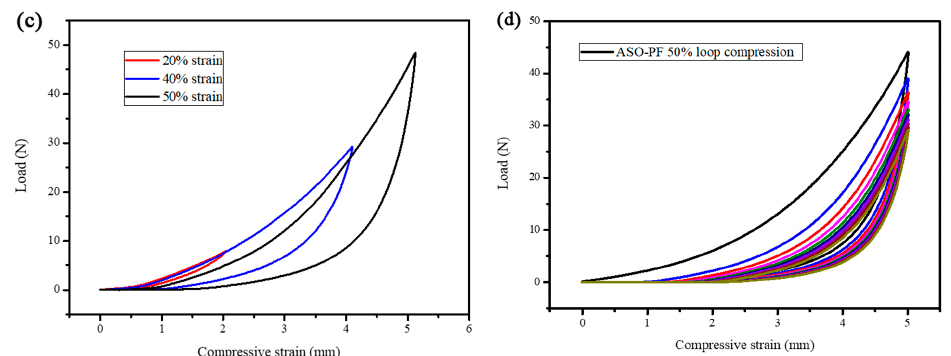
Figure 4. Compressive stress–strain curves of PF and ASO-PF. ( a ) Maximum compressive deformation of PF and ASO-PF, ( b , c ) stress–strain curves for 20%, 40%, and 50% compressive deformation of PF and ASO-PF, respectively, and ( d ) stress–strain curves for cyclic compressive 50% deformation of ASO-PF.